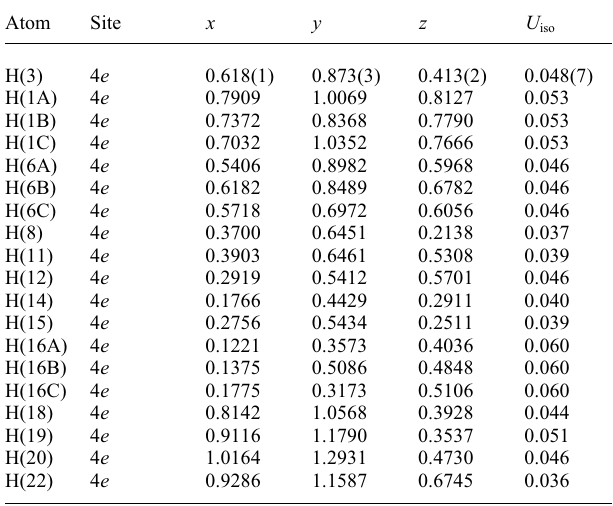
Table 2. Atomic coordinates and displacement parameters (in Å 2 )